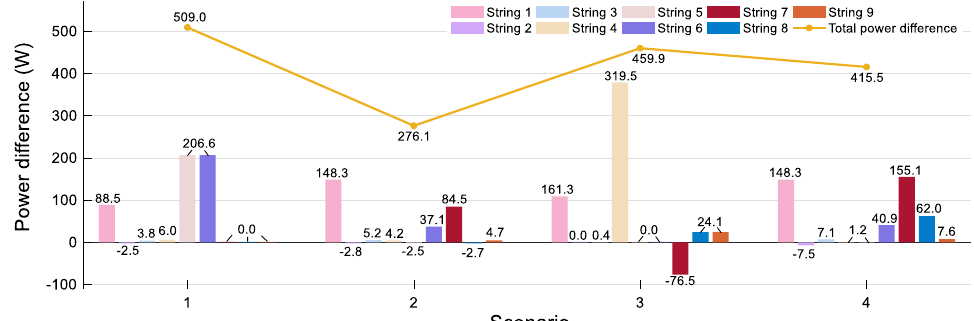
Fig. 10 Maximum power difference of each string between the two evaluated topologies and the total maximum power difference